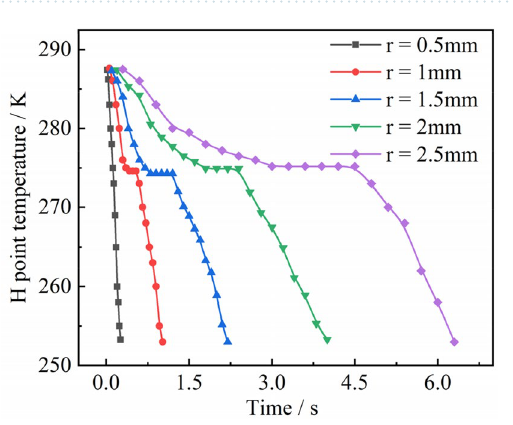
Figure 10. r = 2.5 mm liquid–solid phase volume fraction.